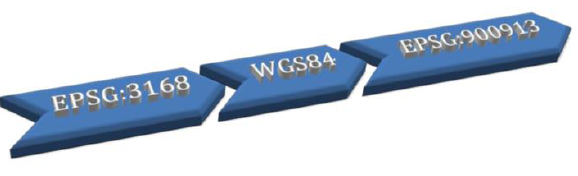
Figure 10. Coordinate Transformation Through WGS84 Map Projection